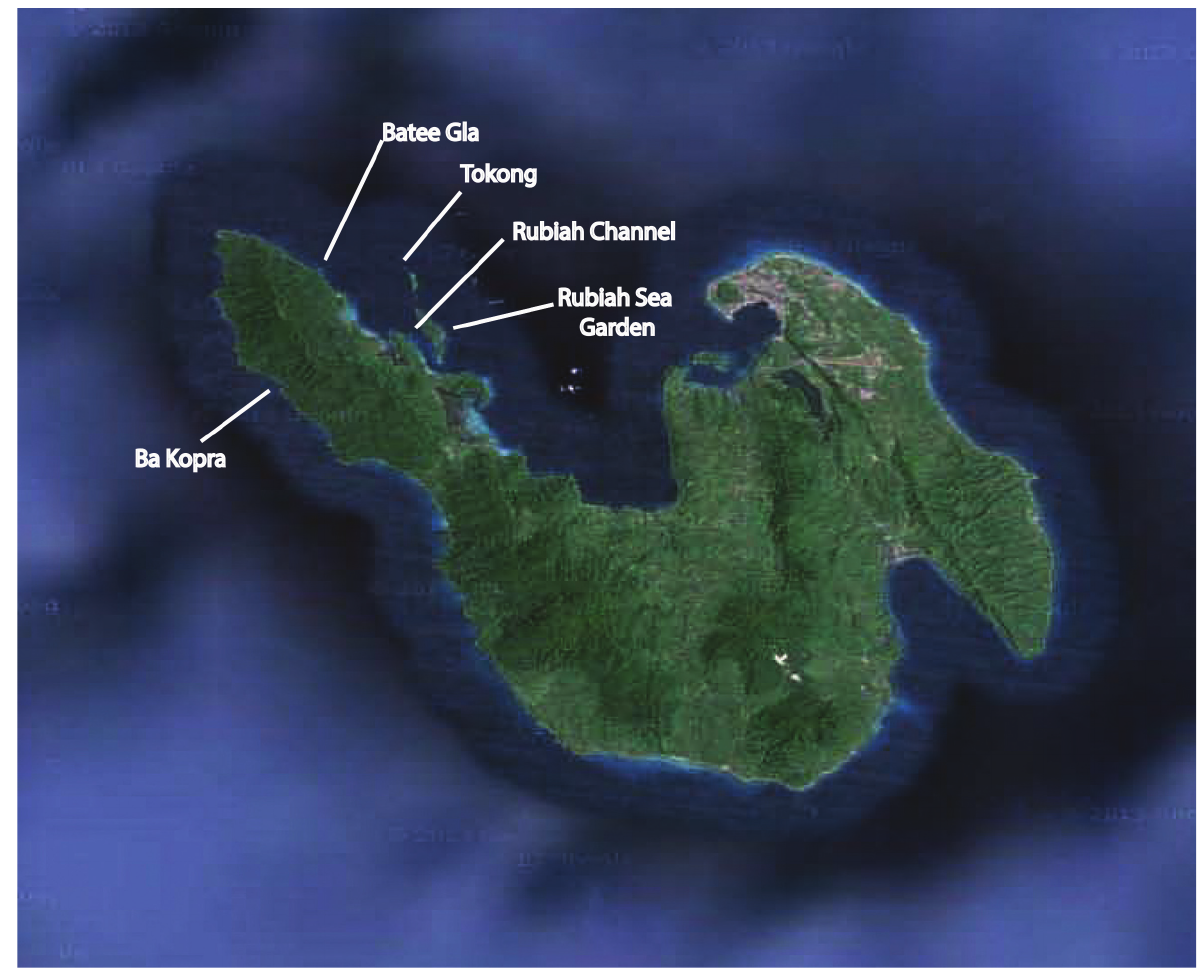
Figure S1. Map of Pulau Weh showing location of study